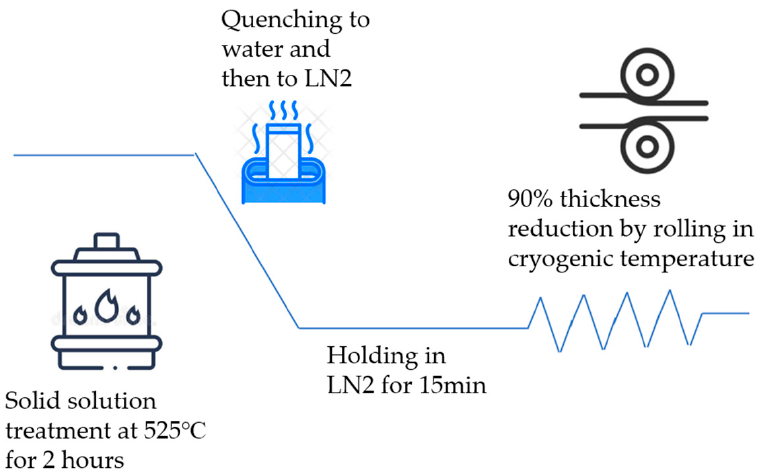
Figure 1. A schematic representation of solid solution treatment and cryogenic rolling.